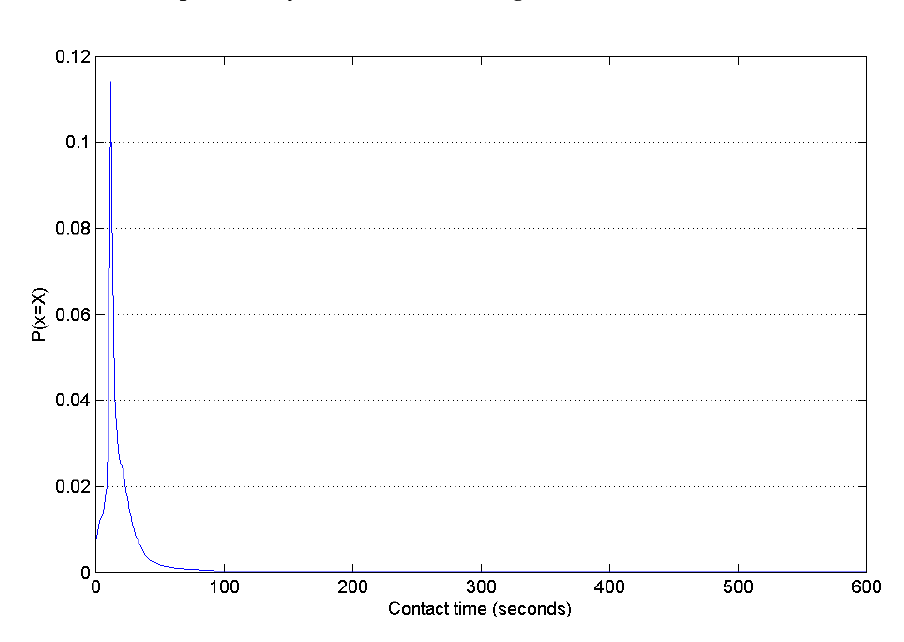
Figure 5. Contact time distribution.